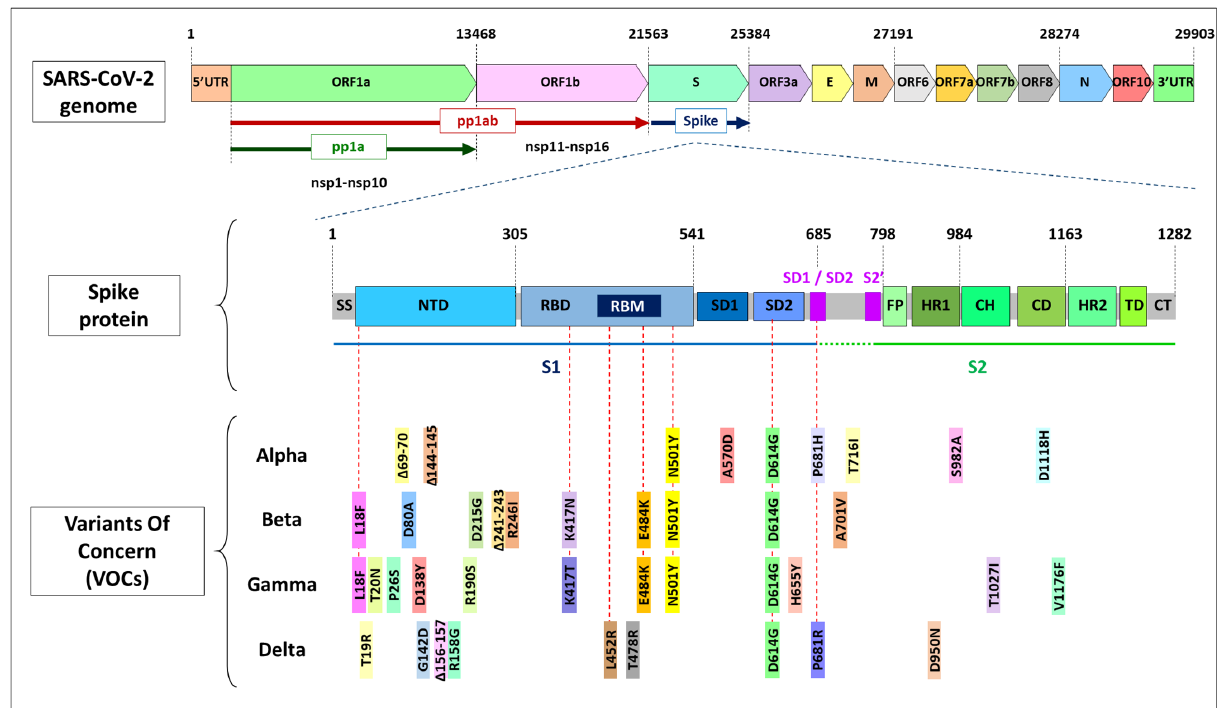
Figure 2. On the top , a schematic view of the SARS-CoV-2 genome that spans almost 30 kb. Polyprotein pp1a produces nsp1–nsp10 and pp1ab generates nsp1–nsp16. In the middle , the detailed structure of the spike protein. SS: signal sequence, NTD: N-terminal-domain, RBD: receptor binding domain, RBM: receptor binding motif, SD: subdomain, FP: fusion peptide, HR: heptad repeat, CH: central helix, CD: connector domain, TD: transmembrane domain, CT: cytoplasmic tail. Cleavage of the spike protein in SD1/SD2 yields spike subunits S1 and S2, activating the virus entry in the host cell. At the bottom , a schematic representation of the mutations included in the VOCs until September 2021. Red dotted lines point out mutations of concern that are shared by different variants.